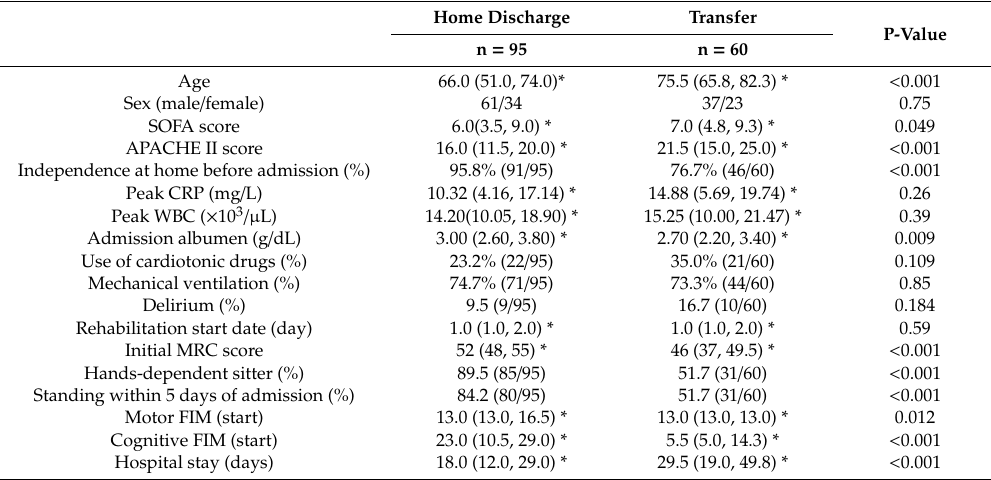
Table 2. Summary comparing home discharge and